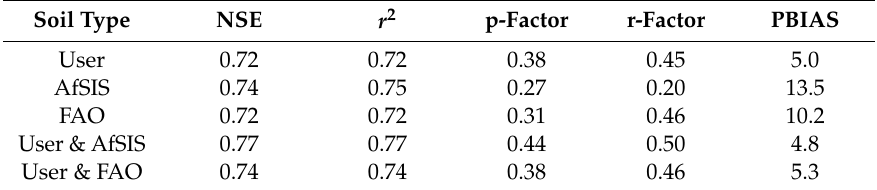
Figure 8. Comparison of observed and simulated monthly sediment yield at the outlet of Anjeni watershed. The simulated sediment yield plots are for the calibrated model parameters. Table 4. Summary of Soil and Water Assessment Tool (SWAT) model performance in simulating monthly sediment yield using different soil datasets at the outlet of the Anjeni watershed.